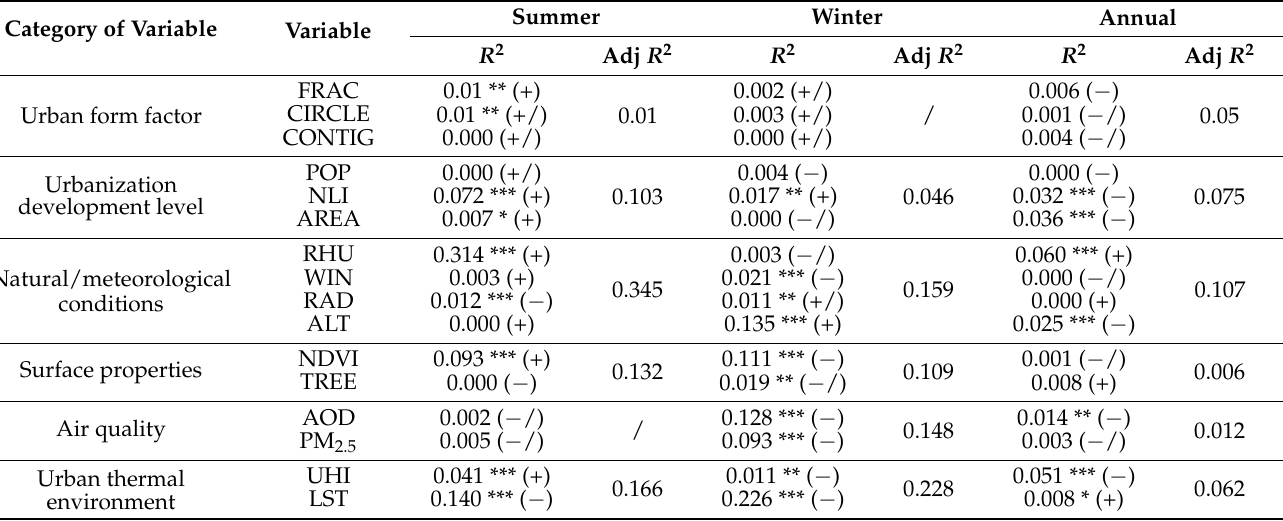
Table 2. Ordinary least squares (OLS) and stepwise regression results for factors affecting urban